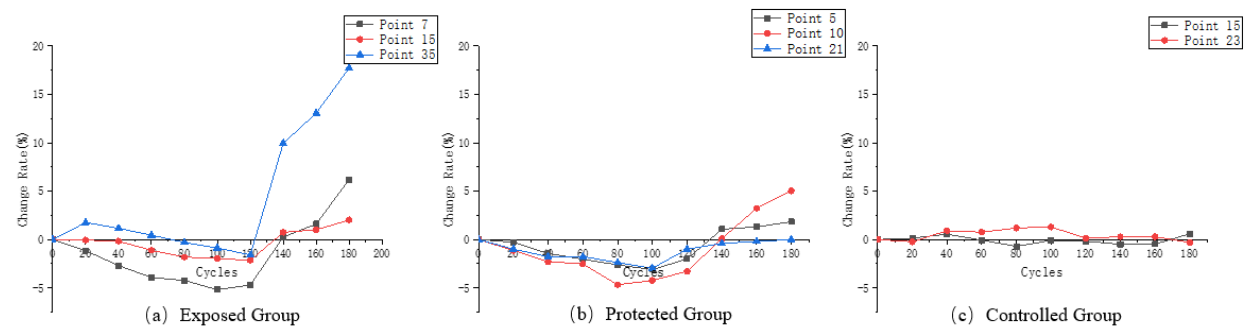
Figure 6. ( a ) Ultrasonic velocity variation rate of the characteristic measurement points of the exposed group; ( b ) ultrasonic velocity variation rate of the characteristic measurement points of the protected group; ( c ) ultrasonic velocity variation rate of the characteristic measurement points of the control group. It can be easily seen from Figure 6a that the final ultrasonic velocity loss of measuring point 35 exceeds 15%, while that of measuring point 7 is only about 1/3 of that of measur- ing point 35. This indicates that in the dry and wet cyclic erosion experiment of the ex- posed group, at the point position at the interface between aggregate and cement paste, the physical salt attack becomes the dominant effect on the structure.